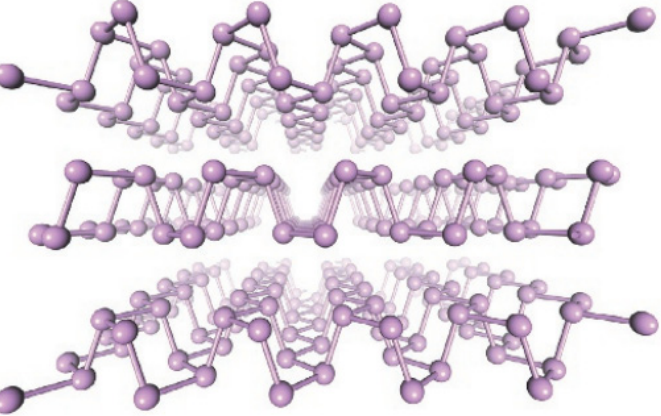
Figure 8. Atomic structure of BP. (Reproduced with permission from ref. [131]. Copyright 2014 Springer Nature Publications).